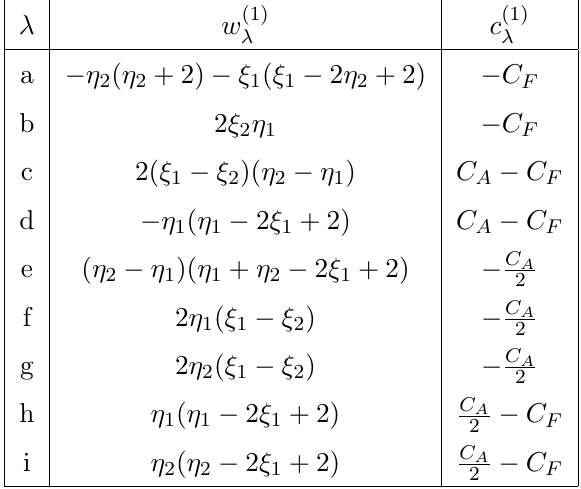
for the diagrams in (cid:12)gure 7. (cid:21)